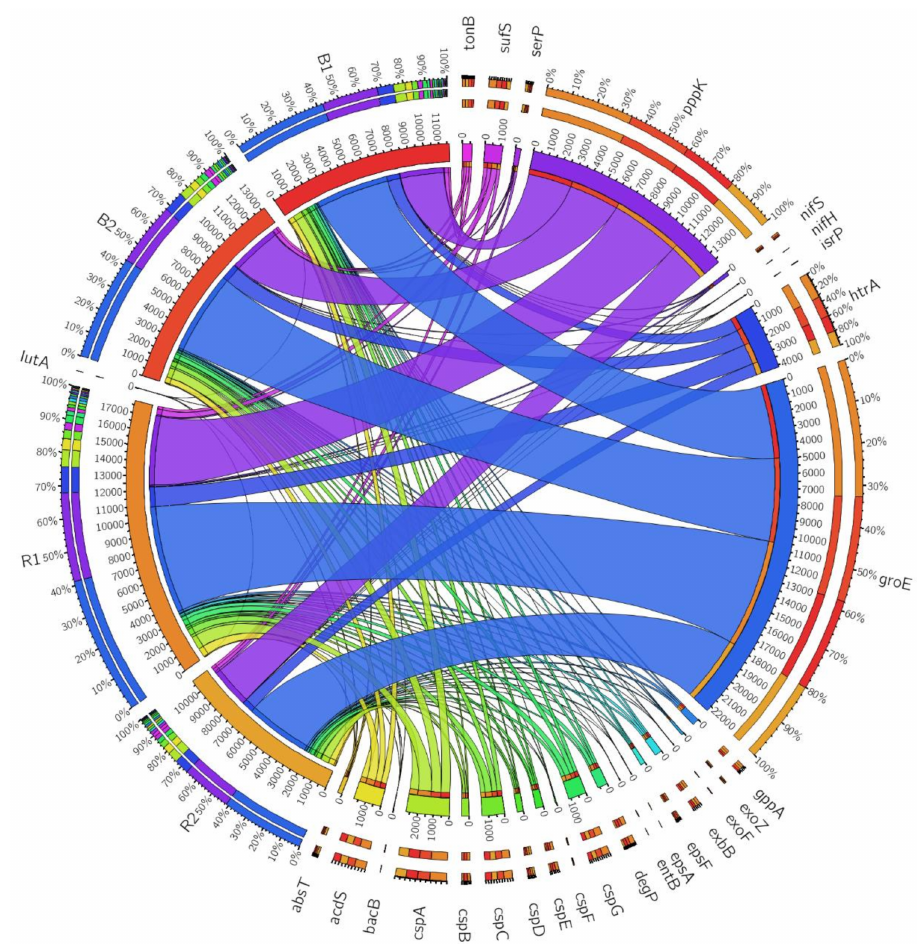
Figure 10. Circos showing the relative abundance of beneficial functional genes obtained from sunflower rhizosphere (R1, R2) and bulk (B1, B2) soil samples. For circos visualization purpose, we coded the genes with no aliases as follows: Siderophore bacillibactin: bacB; Siderophore enterobactin: entB; ABC Fe 3+ siderophore transporter: absT; Iron siderophore receptor protein: isrP; Serine protease: serP; Phosphate solubilization polyphosphate kinase: